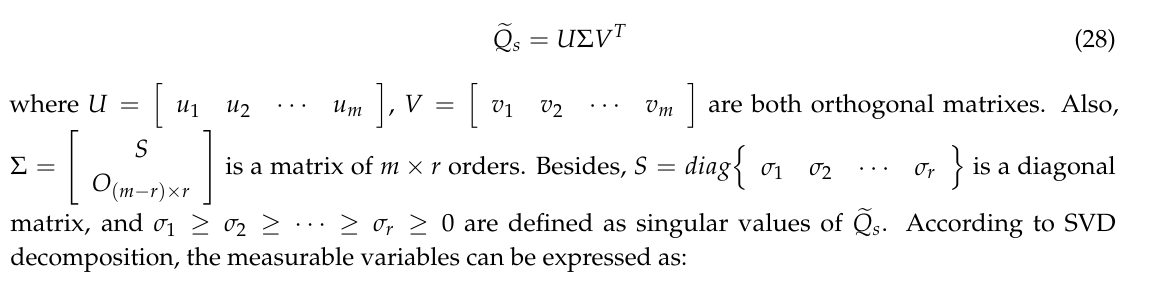
  observability.   and misalignment angles. It